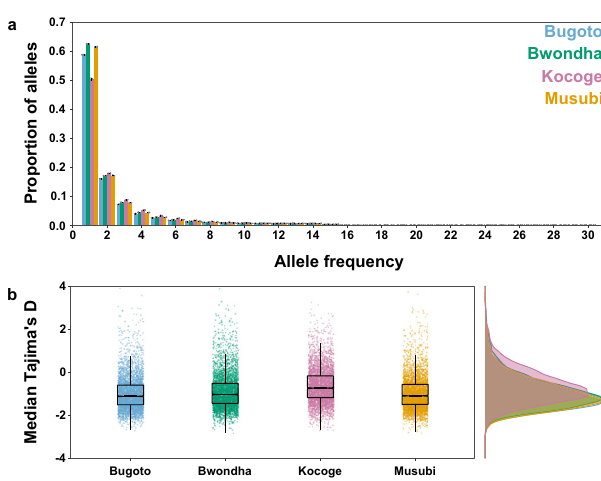
Fig. 3 Genome-wide allele frequency patterns. a One-dimensional site frequency spectra for each parasite population sampled from children in each school: Bugoto (light blue), Bwondha (green), Musubi (yellow) and Kocoge (pink). For each school, miracidial populations were subsampled ( n = 15 miracidia per school) and site frequency spectra were calculated, this was repeated for a total of fi ve replicates. The x -axis represents the derived allele frequency and y -axis represents the proportion of sites at each allele frequency. Coloured bars represent the median proportion of sites across all replicates for each school, black error bars represent the standard deviation around the median for all replicates, grey points represent the individual results for each replicate. b Median Tajima ’ s D values calculated in 5 kb windows across each autosome for each school population. For all boxplots, the central line indicates the median, the top and bottom edges of the box indicate the 25th and 75th percentiles, respectively. The maximum whisker lengths are speci fi ed as 1.5 times the interquartile